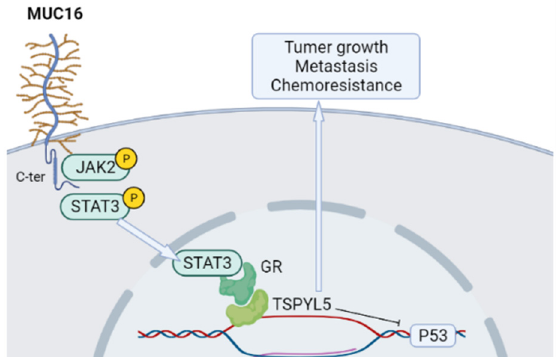
Figure 2. MUC16 chemoresistance signaling pathway in pulmonary tumor cells. MUC16 is essential for the phosphorylation of JAK2 and STAT3, with subsequent STAT3 translocation into the nucleus, in which it is responsible for recruitments of the glucocorticoids receptor (GR) that is responsible for the regulation of the TSPYL5 gene leading to tumor growth and metastasis. MUC16/TSPYL5 is responsible for p53 downregulation associated with chemoresistance. Created with BioRender.com. Globally, lung cancer is considered the most common cancer with the highest inci- dence and mortalities, in particular pulmonary adenocarcinoma, SCLC, and lung squa- mous cell carcinoma. Cisplatin has the greatest importance in treating different subtypes of lung cancer, but this treatment is not beneficial for all individuals; thus, it is very im- portant to determine the resistance or susceptibility of lung cancer patients to platinum- based therapy [90]. A panel of nine genes can precisely predict the sensitivity of patients to cisplatin, which can provide personalized treatment to lung cancer patients to improve their prognosis [90]. High levels of MUC16 in local residents could be one of the molecular characteristics of FLC. Surprisingly, individuals with higher MUC16 up-regulation ap- peared to have fewer white blood cells, particularly neutrophils; this indicates the role of MUC16 in immune regulation. The high levels of MUC16 in cell behavior experiments may be correlated with the proliferation, migration, invasion, and chemoresistance of lung cancer cells [53]. Thatcher et al. [86] formed cisplatin-resistant cell lines through exposure to diverse levels of cisplatin (100 nm—3.6 μ M). The transcript of MUC16 was increased within cis- platin-resistant cell lines ( p = 0.02) when matched with parental cells. These findings sug- gested that MUC16 plays a role in the chemoresistance to lung cancer. To determine the potential role of TSPYL5 in pulmonary cancer chemoresistance, they developed a stable knockdown of TSPYL5 in H292 lung cancer cells, and their results revealed that the ex- pression of p53 was elevated in TSPYL5 knockdown cells when matched with scrambled cells. 6. Muc16 (CA 125) and Non-Malignant Proliferation CA125 is released by embryonic cells [91]. It has recently been used in the prediction, diagnosis, and therapy of pulmonary cancer. The relation between CA125 and tumor size, stage, or histological type has not been studied [92]. In patients suffering from non-malig- nant lung cancer, it may be used as an independent prognostic indicator [93,94]. CA125 is also an effective method for diagnosing lung cancer patients with poor prognoses (PS). Benign pulmonary disease (BPD) is a type of lung disease for which PS tumor markers